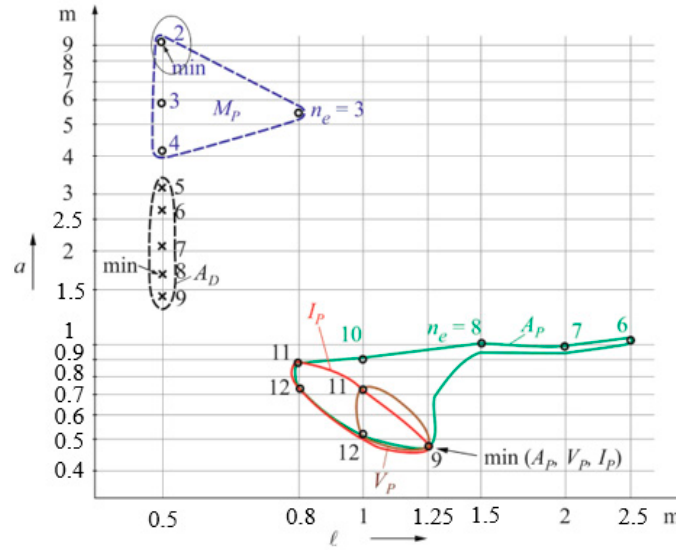
(cid:96) , a) plane, for